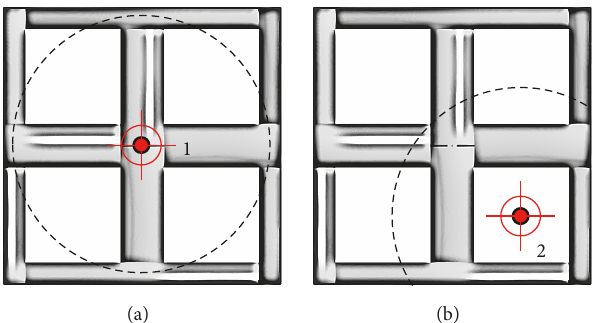
Figure 5: Positioning of the center of impact in numerical experiments: (a) projectile aligned with crossover point; (b) projectile aligned with the center of